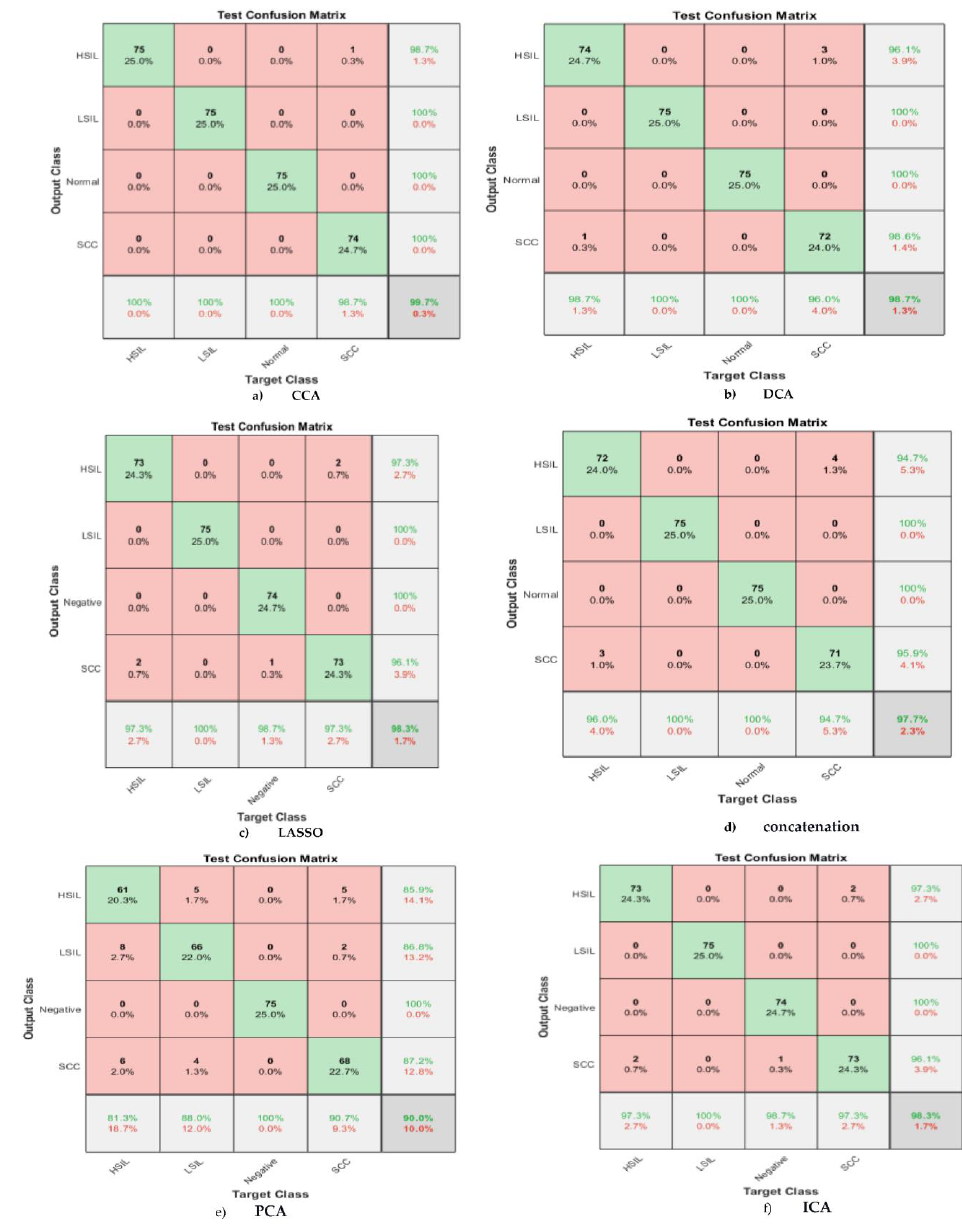
Figure 2. Six confusion matrices of the SVM model when considering six feature fusion techniques. ( a ) Using CCA, ( b ) DCA, ( c ) LASSO, ( d ) concatenation, ( e ) PCA, and ( f ) ICA. The matrices show the performance of the SVM after using different fusion techniques.